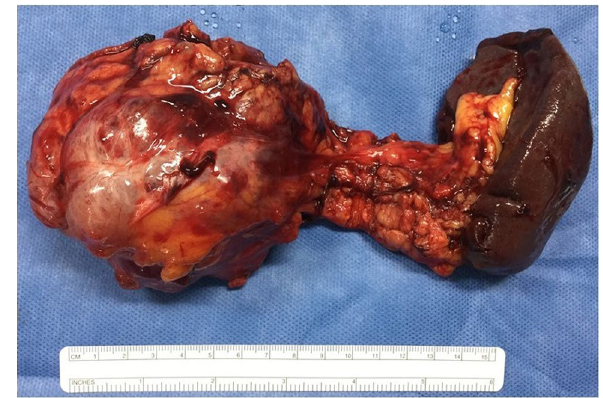
Fig. 1 Solid pseudopapillary neoplasm. Surgical specimen (distal pancreatectomy): large round well-defined tumor located in the pancreas